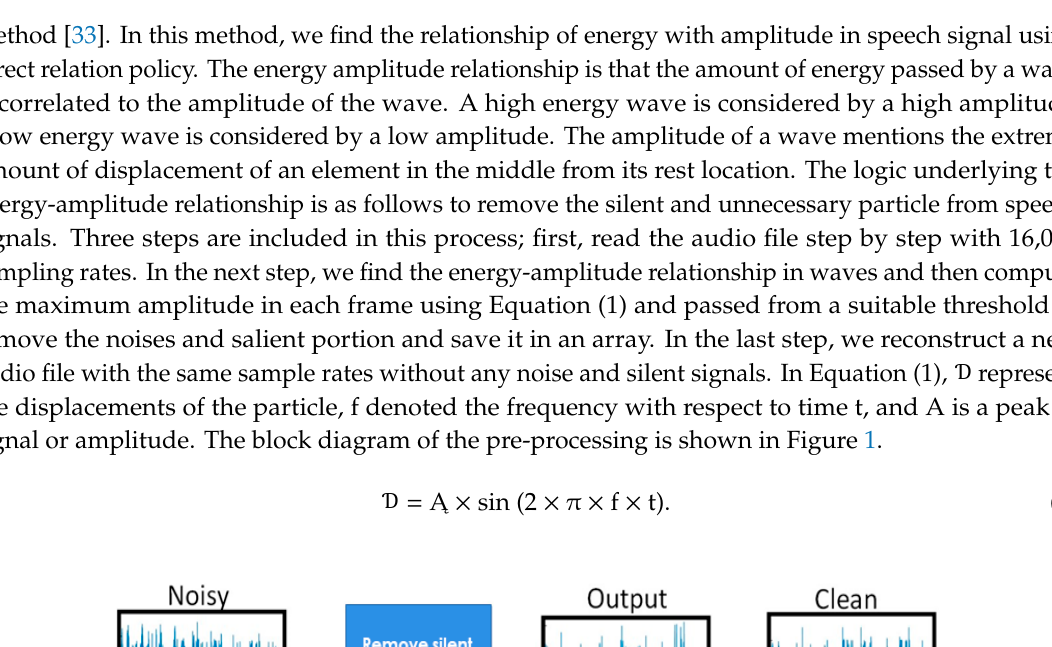
Figure 1. A block diagram of pre-processing to enhance speech signals with an adaptive threshold value.